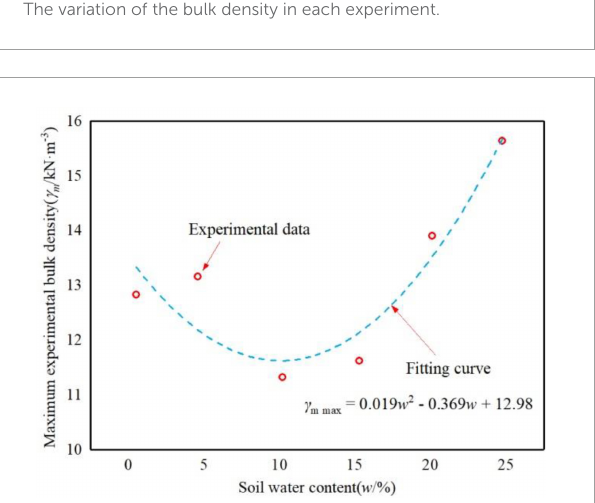
FIGURE7 The variation of the bulk density in each experiment.